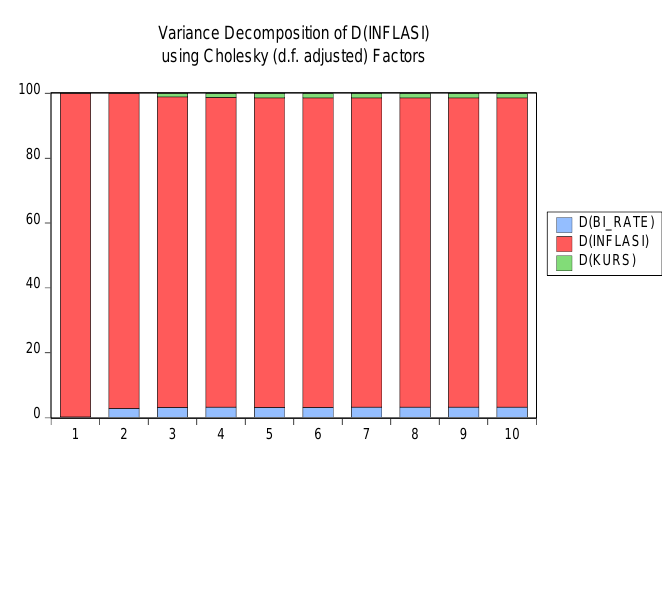
Figure 4: Variance decomposition